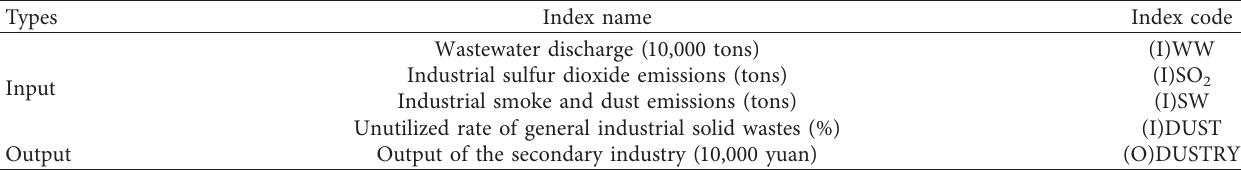
Table 1: Assessment index system.